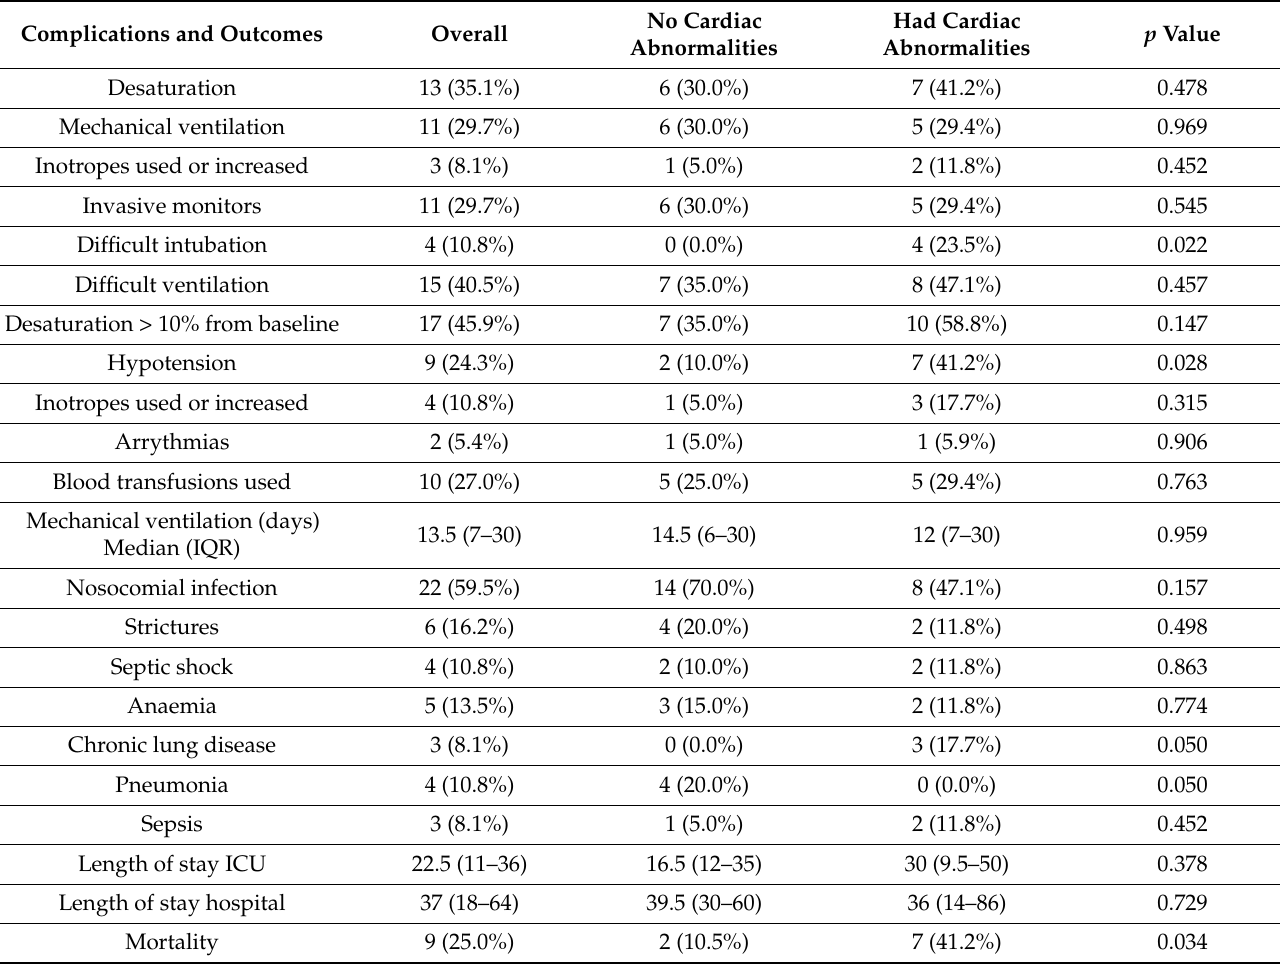
Table 3. Perioperative complications and outcomes between those with and without congenital cardiac abnormalities.